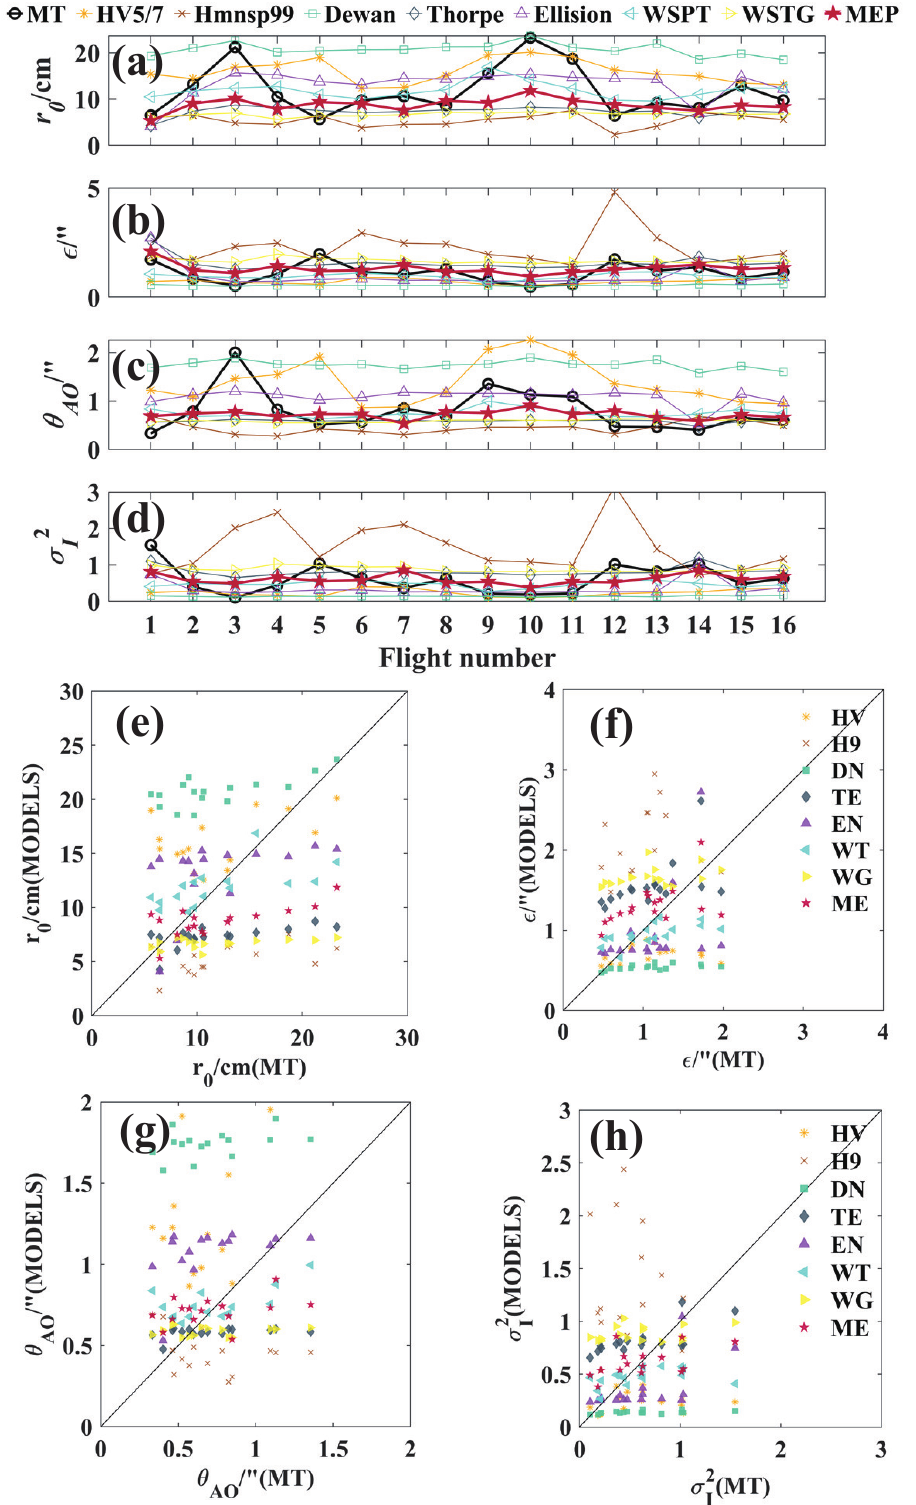
Figure 7. ECACN integrated astronomical parameters (@ λ = 550 nm). ( a ) Fried parameter r 0 (in cm); ( b ) seeing (cid:101) (arcsec in (cid:48)(cid:48) ); ( c ) isoplanatic angle θ AO (arcsec in (cid:48)(cid:48) ); ( d ) scintillation rate σ 2 corresponding scatter